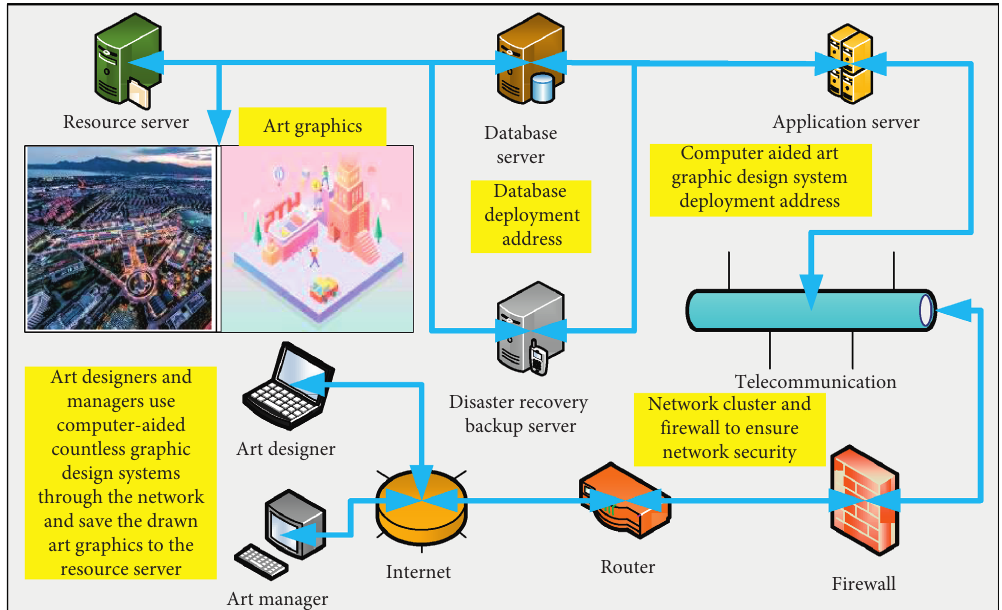
Figure 2: The computer design for the city